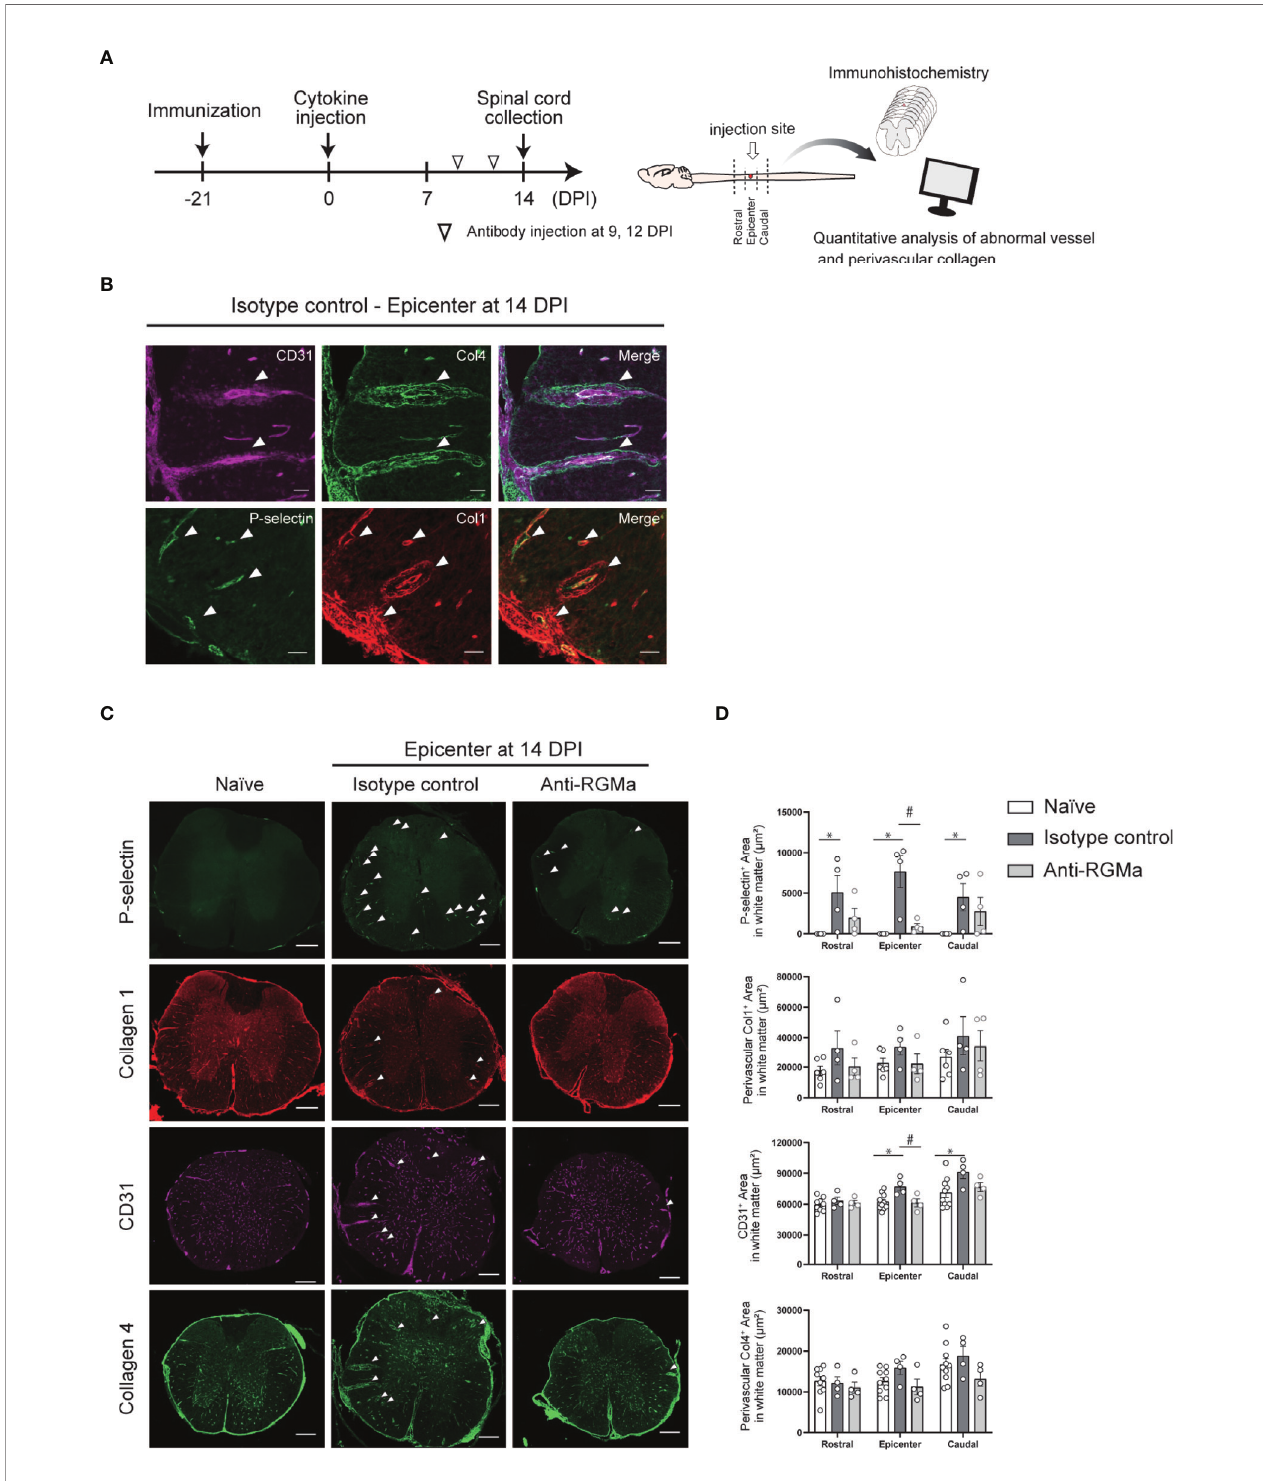
FIGURE 7 | Immunohistochemical analysis of the spinal cord in targeted EAE mice treated by control/anti-RGMa antibody at 14 DPI. (A) Graphical representation of IHC experiments. (B) Representative images of vascular abnormalities at 14 DPI obtained from the isotype control group. (C) Representative images of the spinal cord stained for P-selectin, type I collagen, CD31, and type IV collagen in the naïve (left), isotype control (middle), and anti-RGMa antibody groups (right) at 14 DPI. Arrows indicate abnormal vessels. Scale bar; 50 m m (b, magni fi ed image), 250 m m (c, whole spinal cord). (D) Quanti fi cation of P-selectin, CD31, perivascular type I and IV collagen-positive areas within white matter in each group (naïve; n=8, isotype control; n=4, anti-RGMa; n=4. Error bars represent the mean ± SEM. * p < 0.05 vs naïve, # p < 0.05 vs isotype control, assessed via one-way ANOVA, followed by the Tukey-Kramer